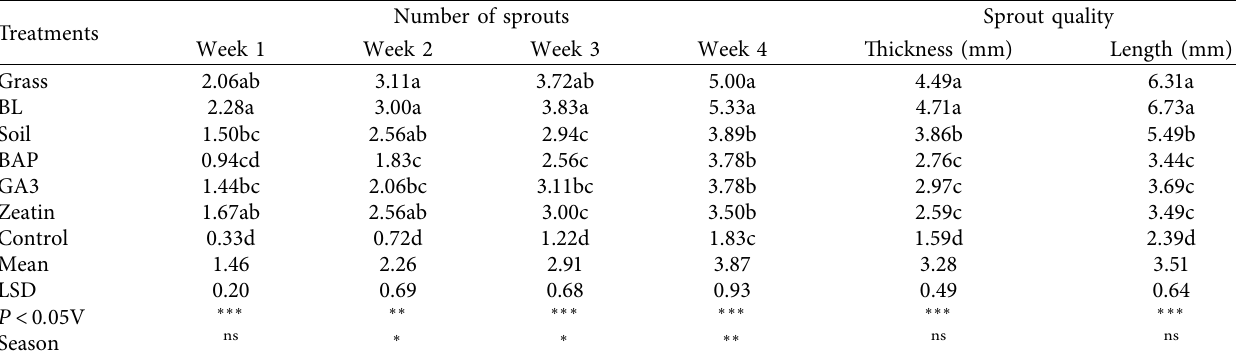
Table 3: Means for the number of sprouts and sprout quality of six plant growth regulators and natural materials under a greenhouse in the